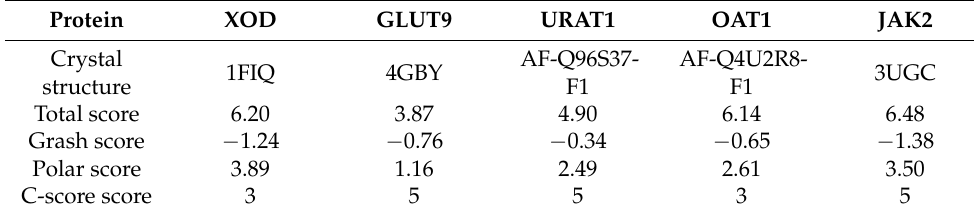
Table 1. Interactions between apigenin with UA transporters and JAK2 protein by molecular docking.